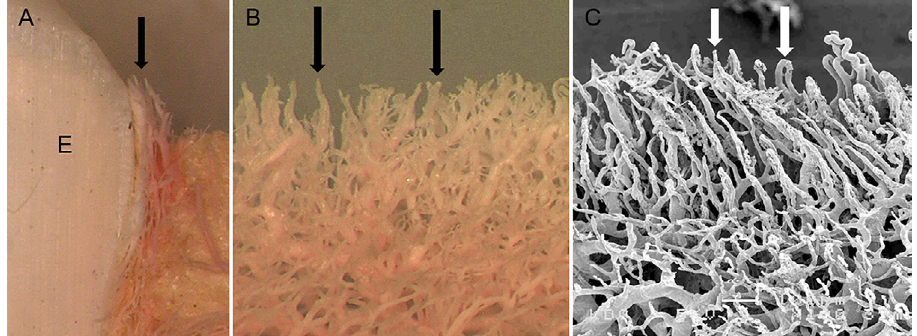
Figure 3- Resin casts of the gingival vascular network in the control group with healthy gingiva. A, B: Gingival blood vessels are attached to the tooth surface (indicated by “E”). Vascular loops are attached along the gingival margin (arrows). C: U-turn vascular loops